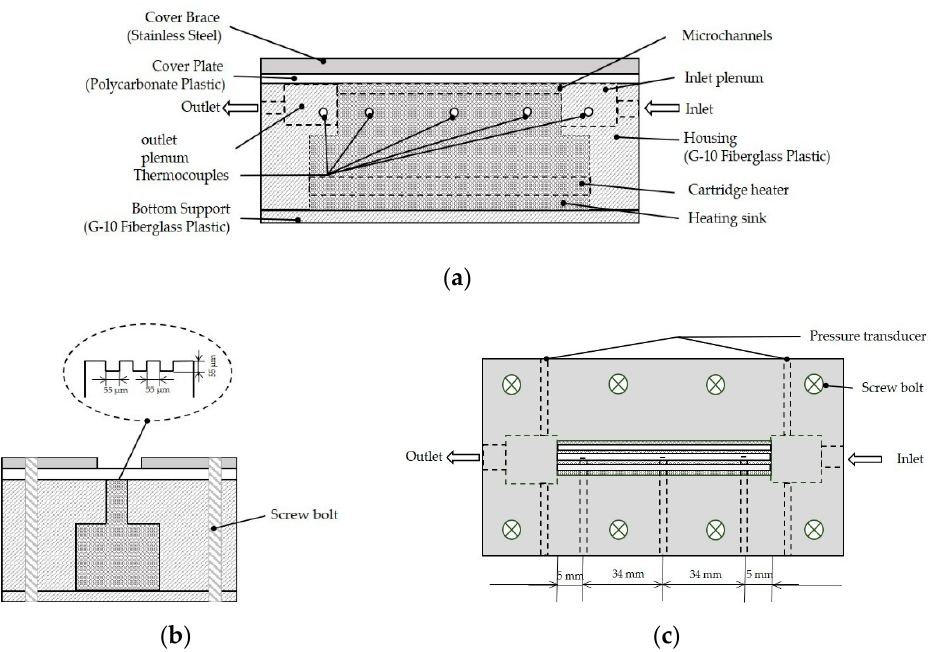
Figure 2. ( a ) Cross-sectional view of the test section; ( b ) construction of the test-section; and ( c ) top view.